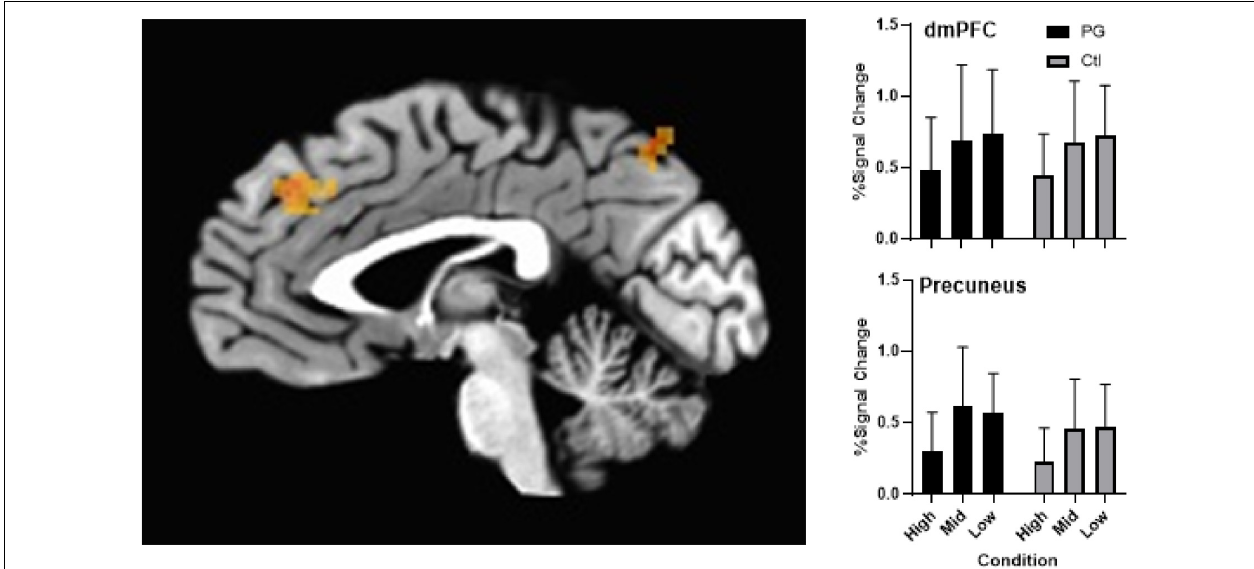
FIGURE 3 | Left panel shows activation differences in the dmPFC and precuneus as an effect of condition (probability) of the probability discounting task during fMRI scan. Upper right panel shows group differences across probabilities in the dmPFC with a main effect of condition (error bars represent mean and SD). Controlling for multiple comparisons, results were significant at p < 0.005. Bottom right panel shows group differences across probabilities in the precuneus with a main effect of condition (error bars represent mean and SD). Controlling for multiple comparisons, results were significant at p <